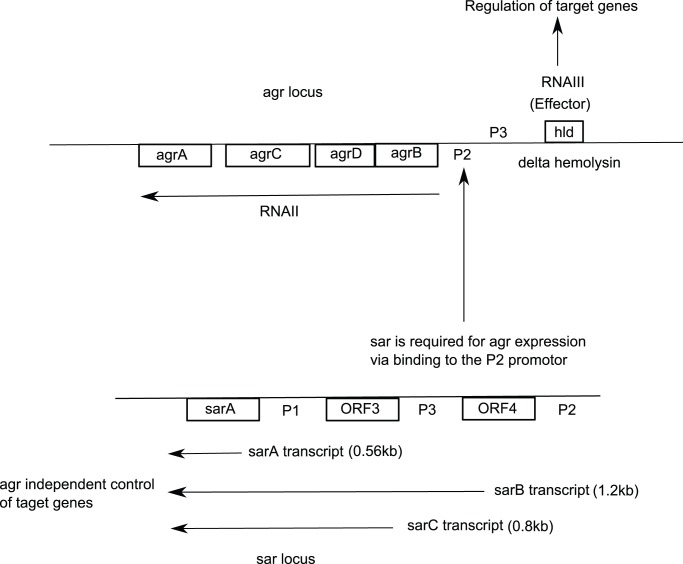
agr and sar loci from S. aureus, adapted from [140].